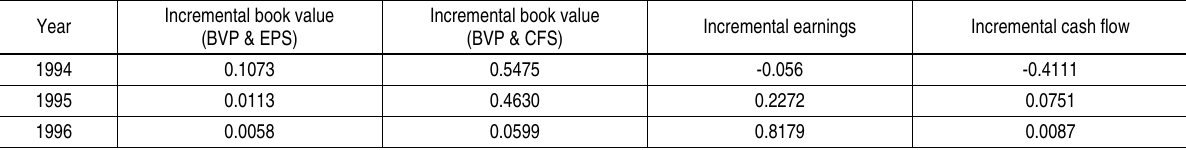
Table 6. Analyses of the incremental information content of book values, cash flows and